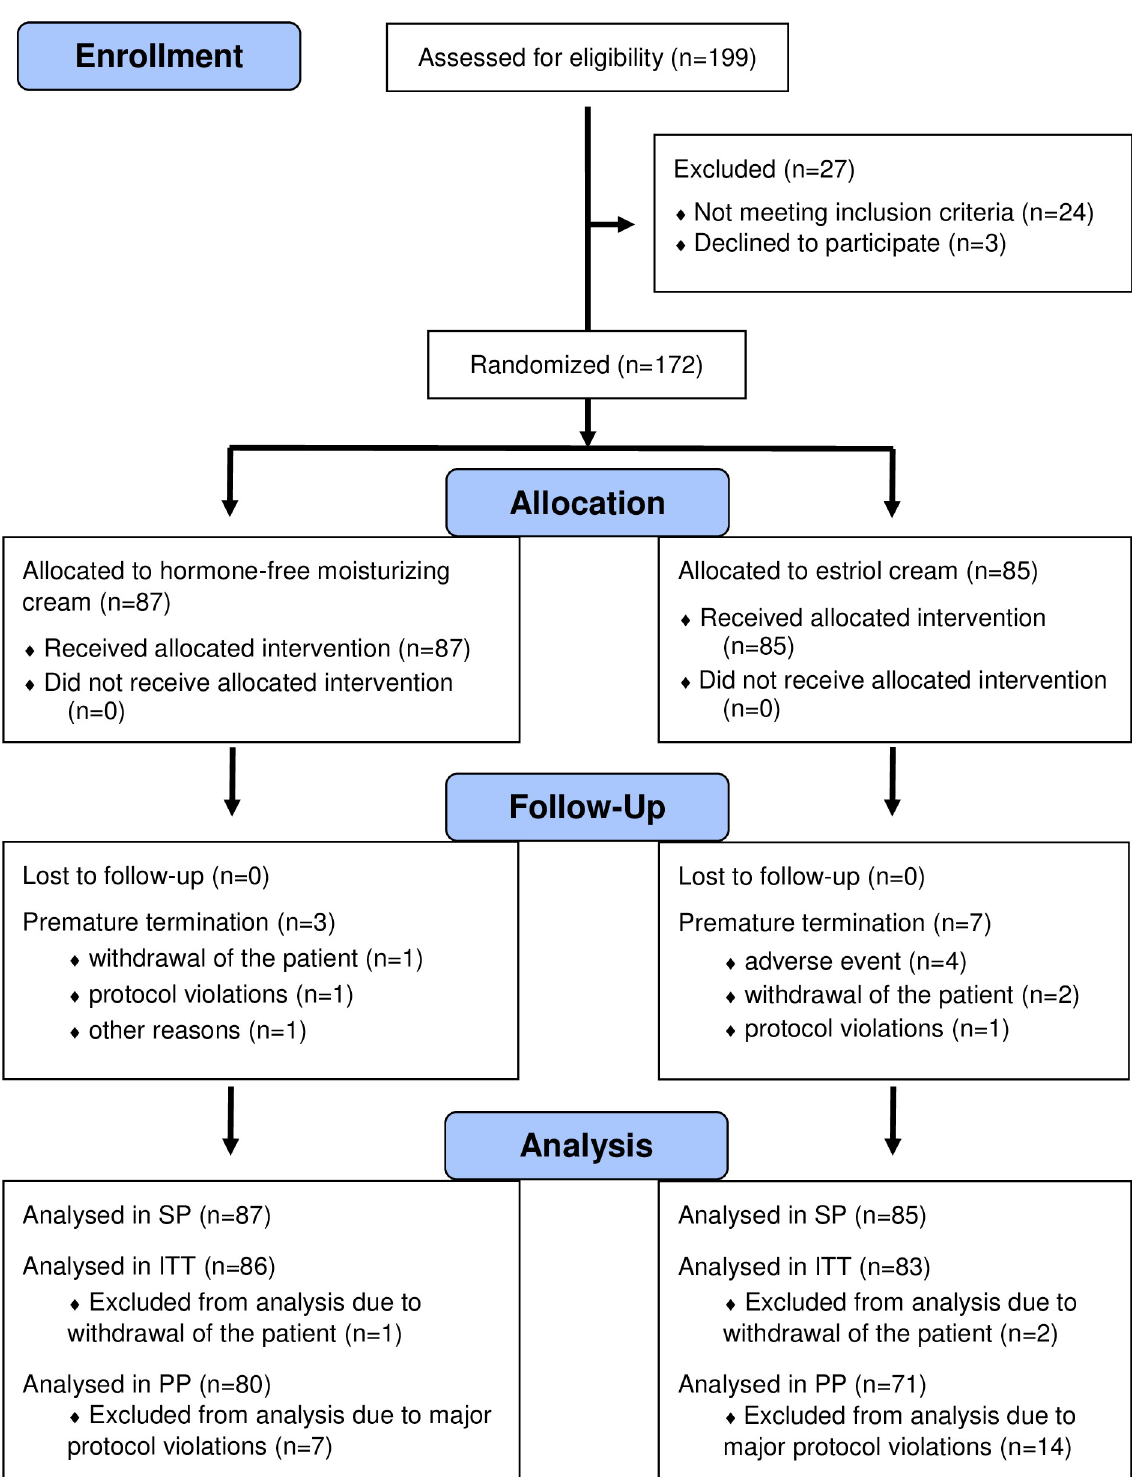
Fig 1. CONSORT flow diagram. Disposition of patients. SP, Safety Population; ITT, Intention-To-Treat Population; PP, Per Protocol Population.